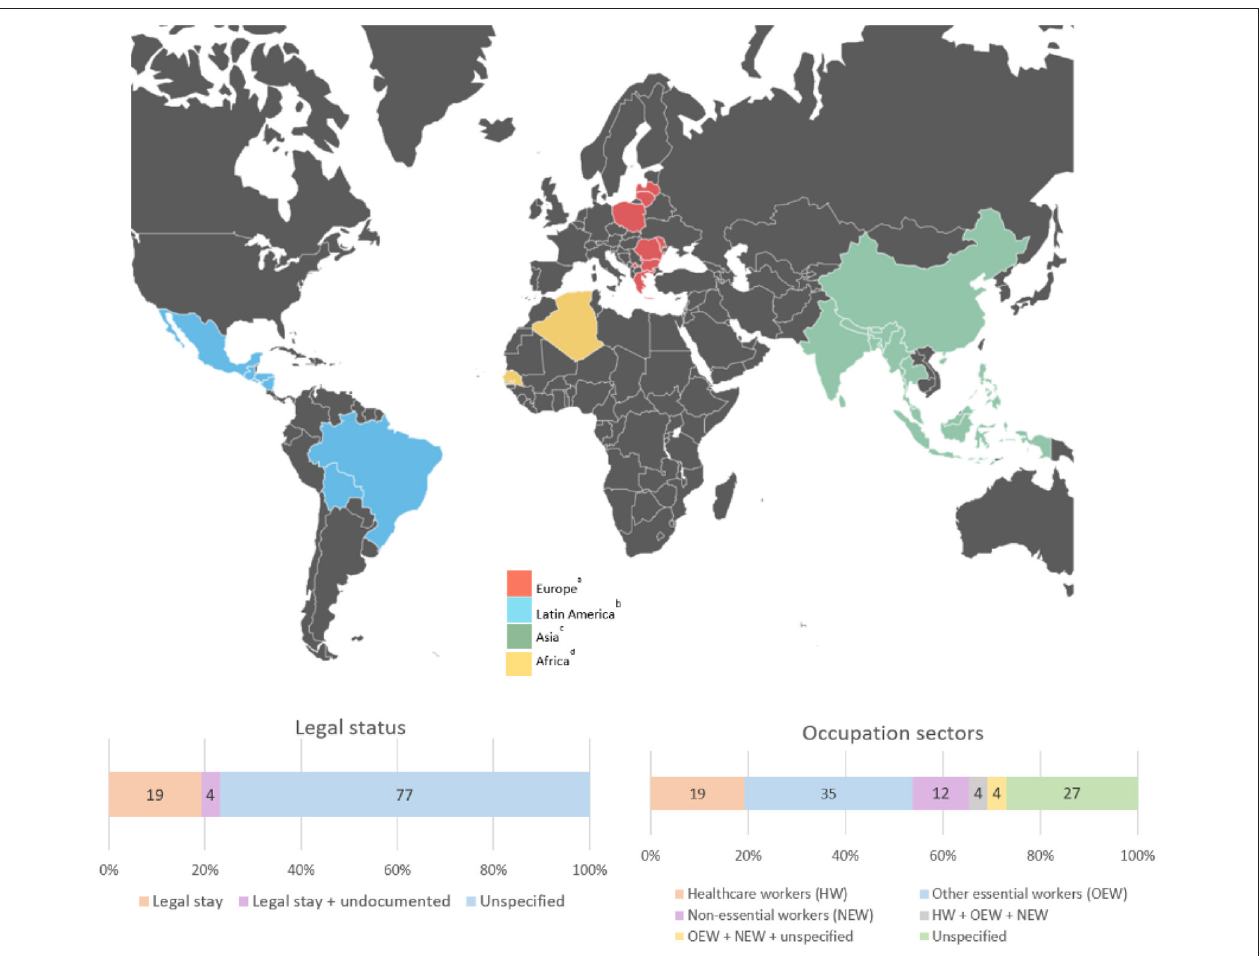
FIGURE 2 | Country of origin, legal status, and occupation sectors of the migrant samples of the 26 studies selected. a Romania, Poland, Greece, Latvia, Moldova, Lithuania, Bulgaria, and Kosovo. b Mexico, El Salvador, Guatemala, Honduras, Nicaragua, Bolivia, and Brazil. c Philipines, India, Sri Lanka, Nepal, Bhutan, Myanmar, Bangladesh, Malaysia, Thailand, China, and Indonesia. d Algeria and